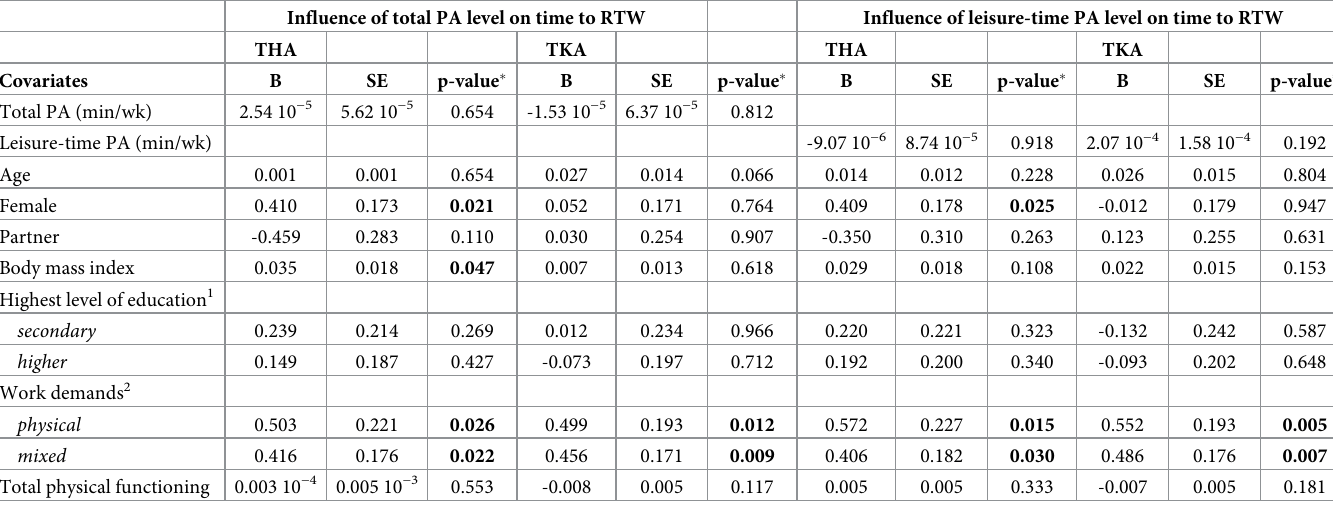
Table 3. Results of the multiple regression analyses for total and leisure-time PA levels and RTW, for THA and TKA patients separately. Influence of total PA level on time to RTW Influence of leisure-time PA level on time to